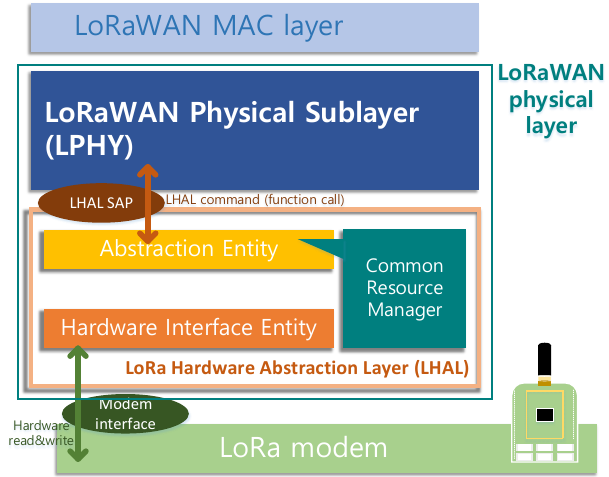
Figure 2. The layered architecture of the PHY layer